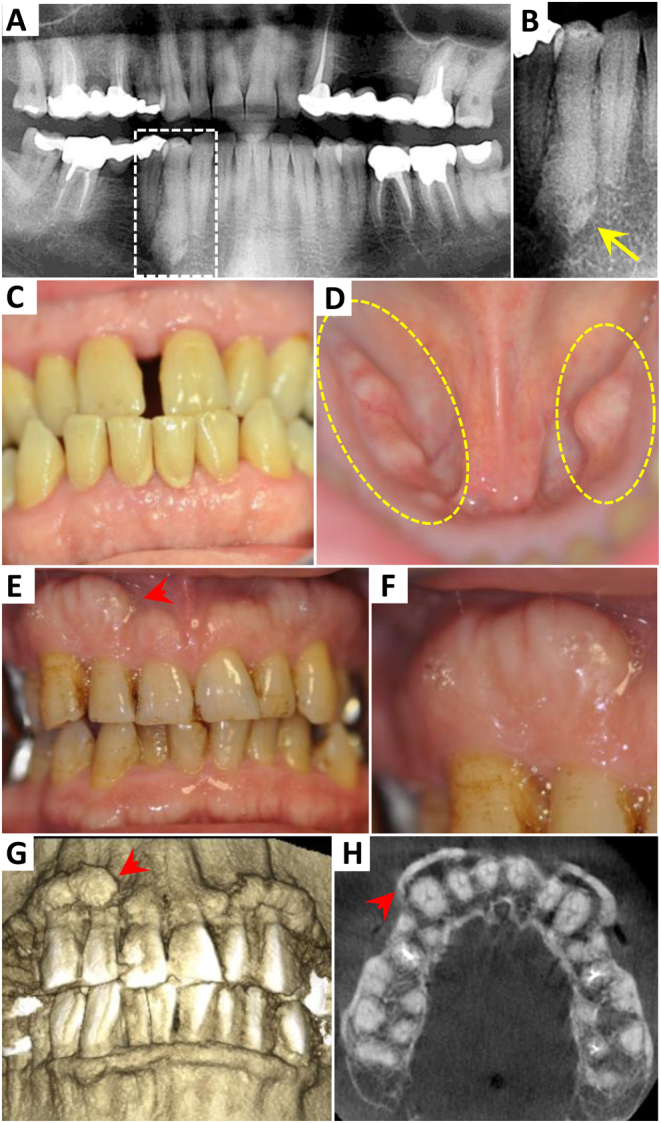
Acromegalic patients had frequent thick gingival biotype and oral bony outgrowths but no diffuse hypercementosis. (A) Orthopantomogram of an acromegalic patient recovering an isolated cementoma of the tooth 44 but no diffuse hypercementosis. (B) Enlargement of the dotted line delimited area in A, yellow arrow: cementoma. (C, D and F) Photographs of oral cavity of acromegalic patients showing: (C) thick gums without gingival hypertrophy nor periodontitis. Note the maxillary central diastema and occlusion disorder (class III); (D) presence of bilateral mandibular tori (circled in dotted line); (E) presence of vestibular bony outgrowths; (F) magnification of the bony outgrowth pointed by a red arrowhead in E; (G) 3D reconstruction from Cone beam CT (CBCT) of the same patient as in E; (H) CBCT slice through maxillary of the same patient as in E. Red arrow heads in E, G and H point to the same vestibular bony outgrowth, note the cortical bone enlargement H.